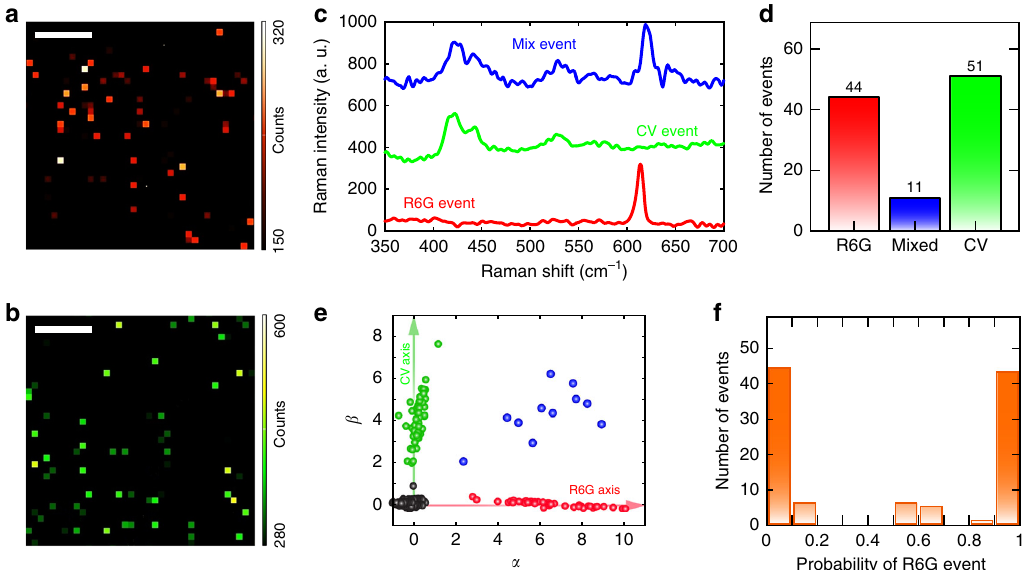
Fig. 4 Bi-analyte single-molecule detection base on MPCA. a 2D Raman mapping of the peak intensity at a 613 cm − 1 corresponding to R6G. The scale bar represents 5 µ m. b 2D Raman mapping of the peak intensity at a 414 cm − 1 corresponding to CV. The scale bar represents 5 µ m. c Typical spectra for bi- analyte analysis. The details of all the spectra can be found in the Supplementary Note 10. d Histogram of occurrences of pure R6G, pure CV and mixed events. e Coef fi cient ( α , β ) plot of the spectra based on the eigenvectors from MPCA. The axes represent two principle eigenvectors that corresponds to the R6G (red) and CV (green) events. The points in between and near the origin corresponds to the mixed events (blue) and null events (black) respectively. f Single-molecule probability histogram derived from MPCA, providing a clear sign for sensitivity at single-molecule